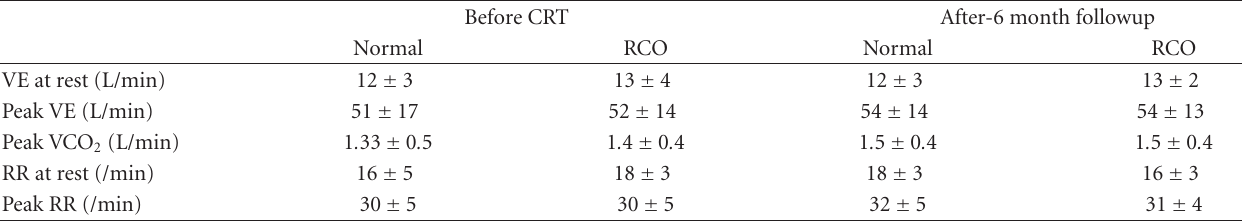
Table 2: Comparison of ventilatory data during rest and peak exercise with and without RCO before and 6 months after CRT. Values are given as means ± SEM. RCO, regional circulatory occlusion, RR, respiratory rate, VE, minute ventilation.